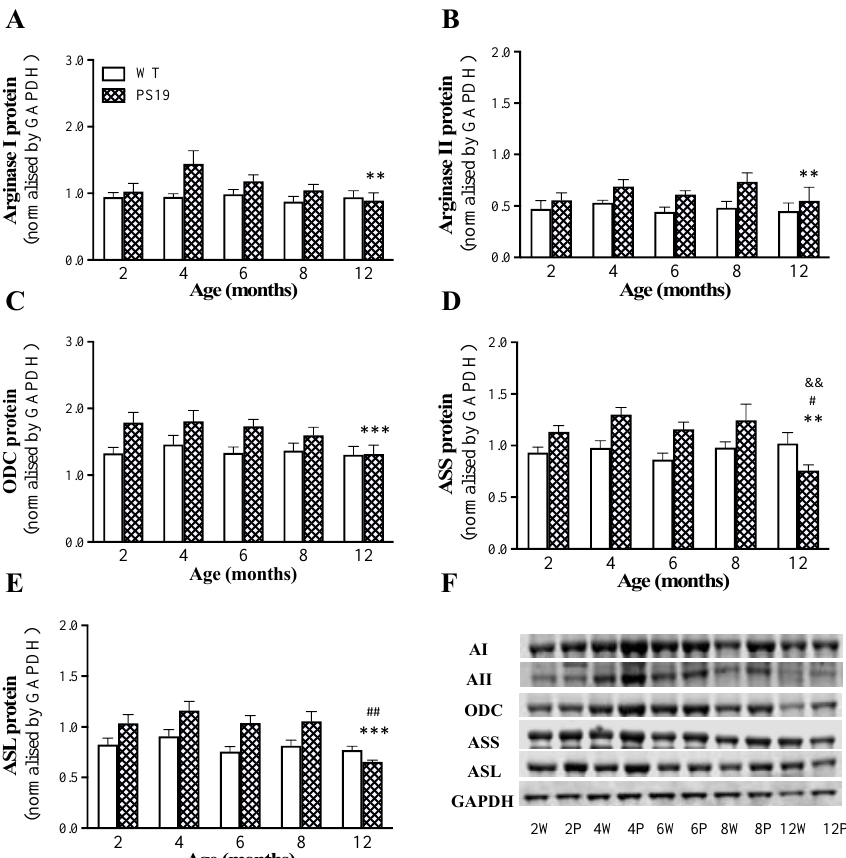
Figure 6. Mean ( ± SEM) protein expression of arginase I (AI; A ), arginase II (AII; B ), ornithine decarboxylase (ODC, C ), argininosuccinate synthetase (ASS, D ) and argininosuccinate lyase (ASL, E ) in the parahippocampal region of wildtype (WT) and PS19 mice at 2, 4, 6, 8 and 12 months of age (n = 7–9/genotype/age). ( F ): representative western blots of AI, AII, ODC, ASS and ASL, as well as housekeeping protein glyceraldehyde 3-phosphate dehydrogenase (GAPDH), in wild-type (W) and PS19 (P) mice at five age points. && indicates a significant genotype and age interaction at p < 0.01. # indicates a significant age effect at # p < 0.05 or ## p < 0.01. * indicates a significant genotype effect at ** p < 0.01 or *** p < 0.001.